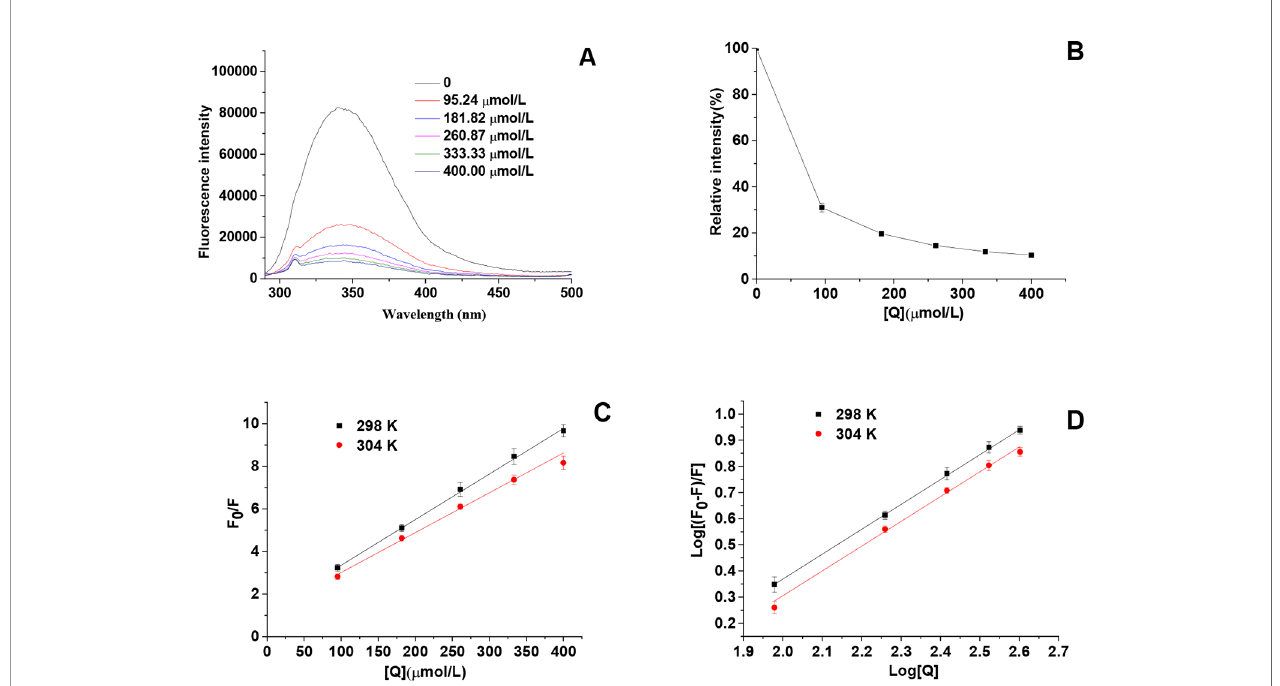
FIGURE 5 | (A) Intrinsic fl uorescence spectra of tyrosinase in the presence of HgCl 2 at various concentrations, which were 0, 95.24, 181.82, 260.87, 333.33, and 400.00 m mol/L for curves, respectively. (B) Relative intensity (%) of tyrosinase at various concentrations of HgCl 2 (298K). (C) The Stern – Volmer plots for the fl uorescence quenching of tyrosinase at various temperatures (298 and 304 K). (D) Plots of log [(F F 0 and F are the fl uorescence intensities of tyrosinase in the absence and presence of HgCl 2 , and [Q] represents the concentration of HgCl 2 . The experiment was repeated three times (n =